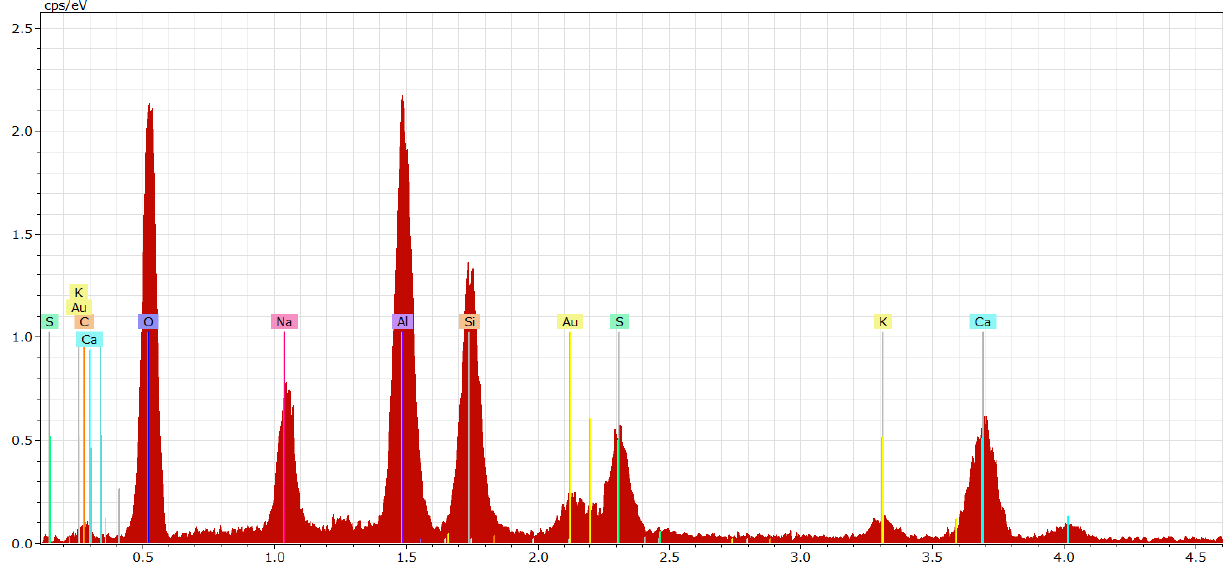
Figure 11. The result of the EDX analysis of the haüyne crystal (placed according to Figure 10a).